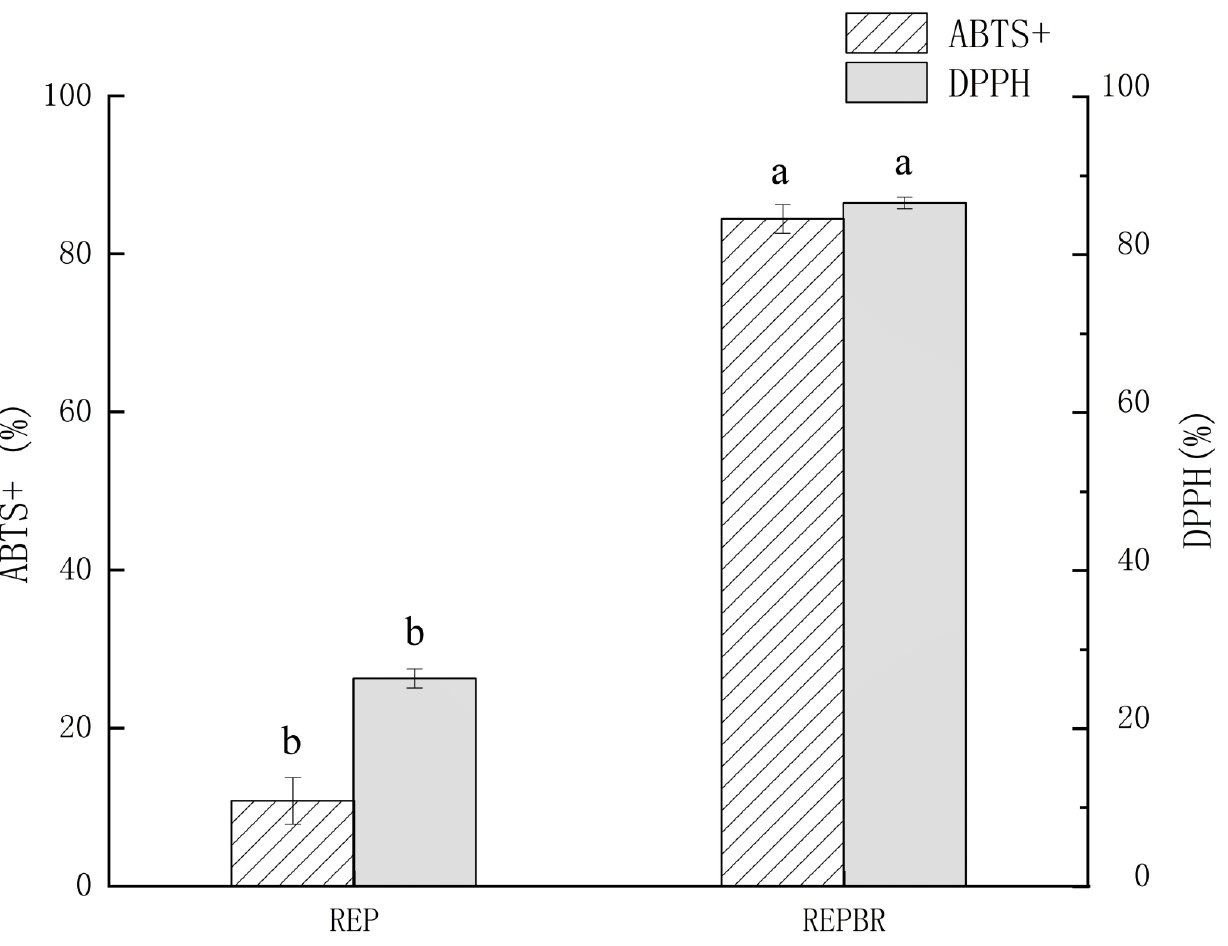
Figure 1. DPPH and ABTS+ radical scavenging efficiency of REP and REPBR. Different superscript letters are significantly different ( p < 0.05 ).